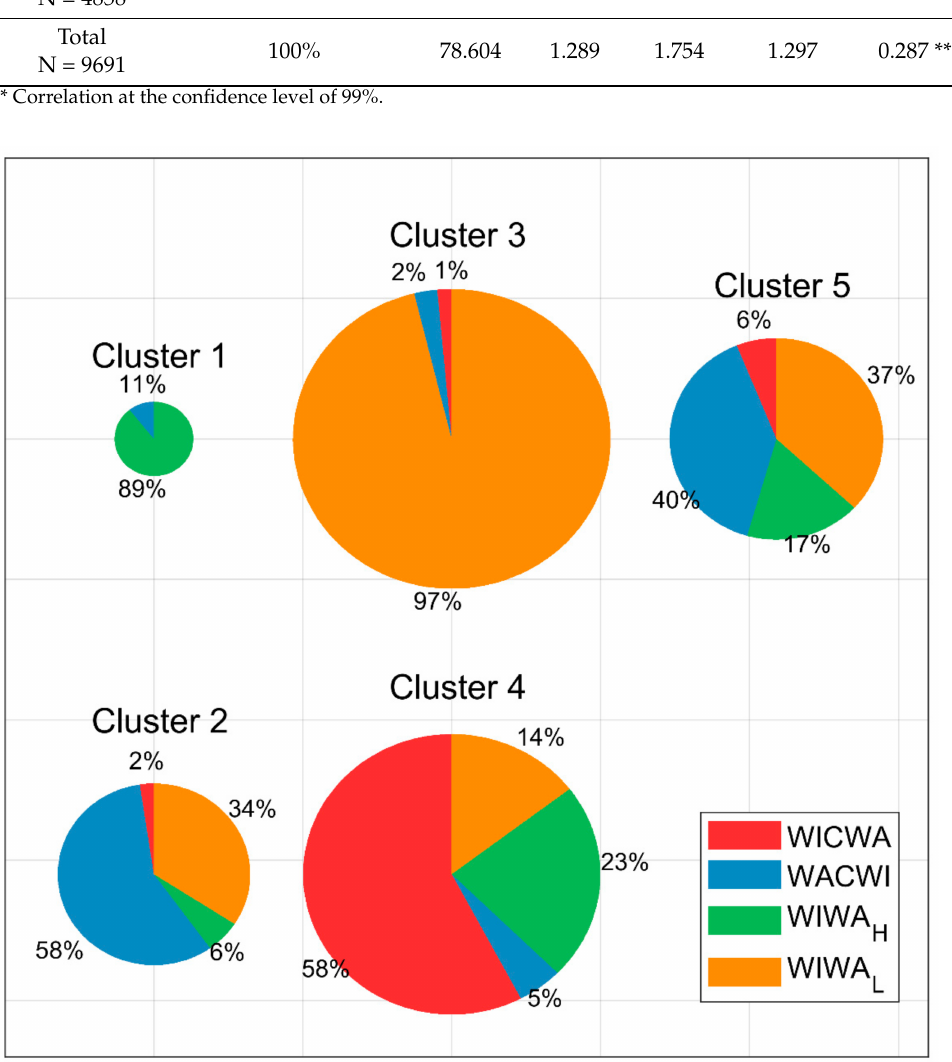
Figure 5. Energy patterns between the two resources of different meteo-climatic clusters. The disc area indicates sampling size of each cluster. The colored sectors of each disc are the percentage of the synergy